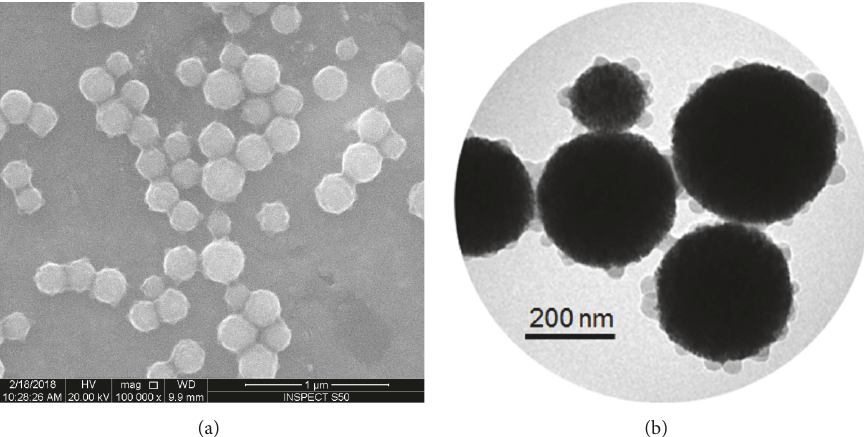
Figure1:(a)StructureoffluorescentmagneticsubmicronicpolymerFMSP-nanoparticlesthroughScanningElectronMicroscope(SEM)with 100,000 x magnification. (b) Structure of fluorescent magnetic submicronic polymer FMSP-nanoparticles through Transmission Electron Microscope (TEM) with 70,000 x magnification.